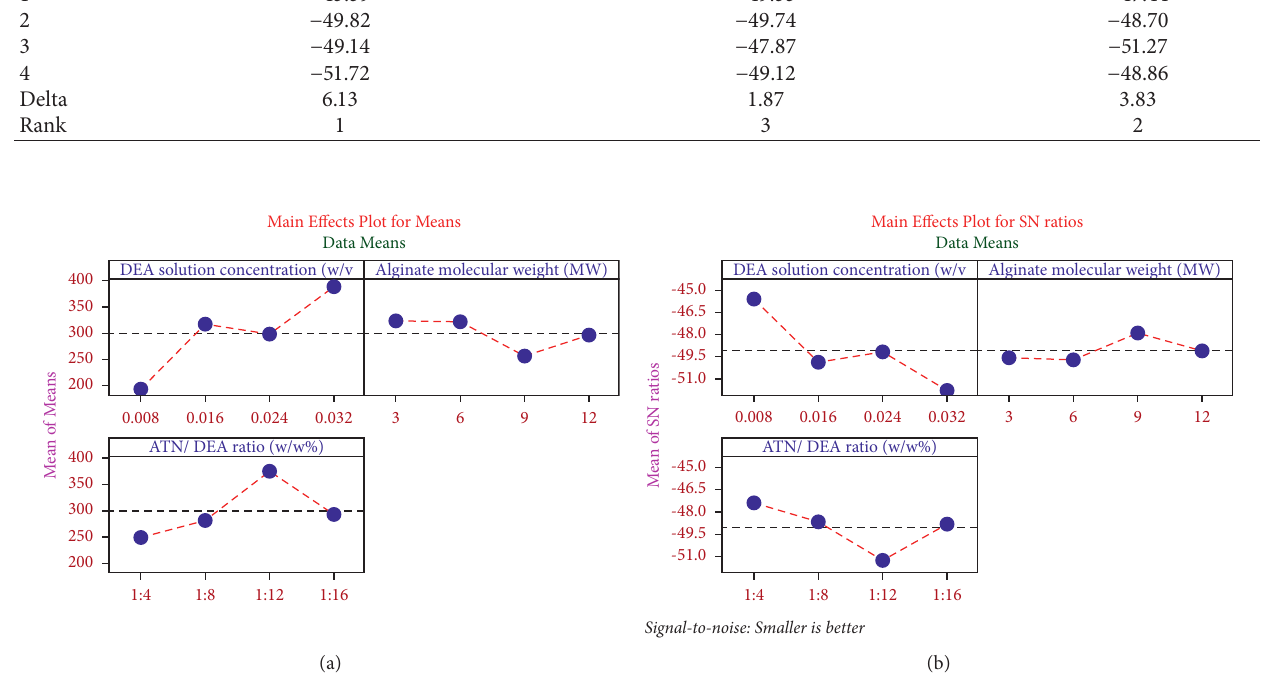
Figure 2: Main effects plot for (a) mean of particle size and (b) S/N ratio of particle size.